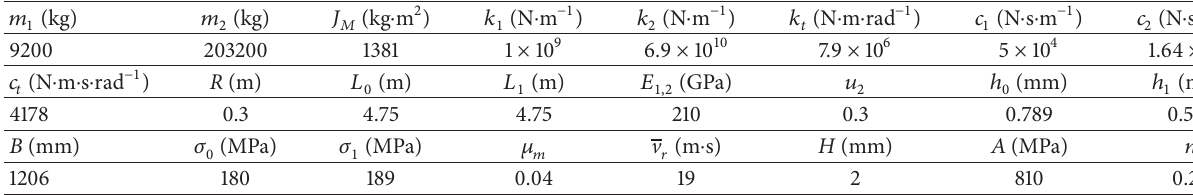
Table 1: Parameters of mill structure, rolling process, and strip material.